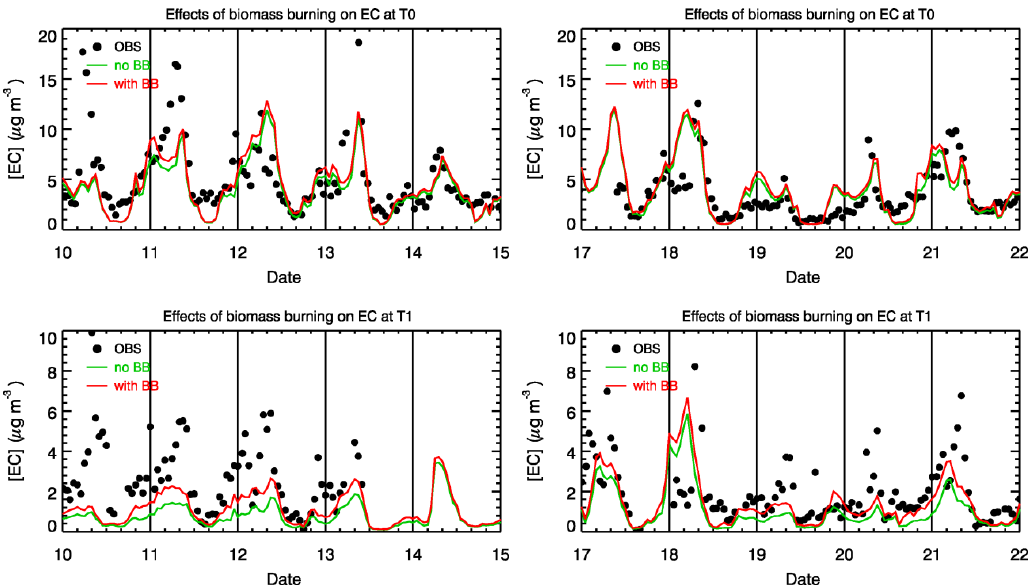
Fig. 9. Comparisons of observed and simulated elemental carbon particulates at T0 and T1. The adjusted BB emissions were used in the